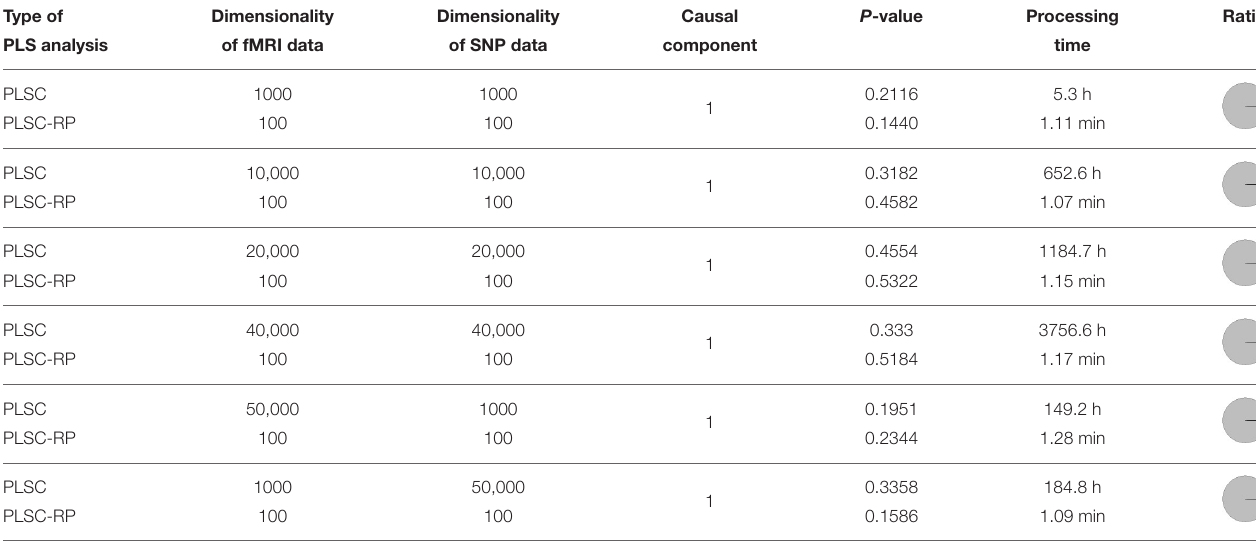
TABLE 3 | PLSC and PLSC-RP results for high-dimensional neuroimaging and high-dimensional SNP data. Type of Dimensionality